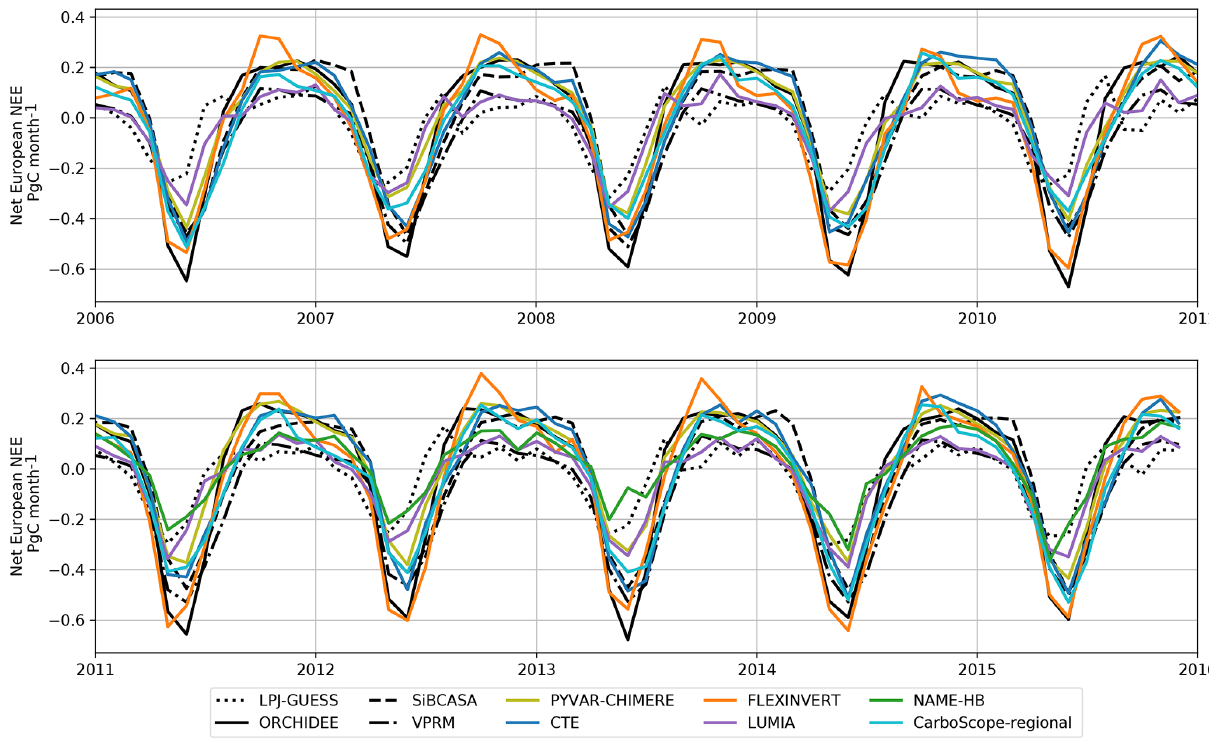
Figure 4. Monthly posterior fluxes, aggregated on the entire domain.